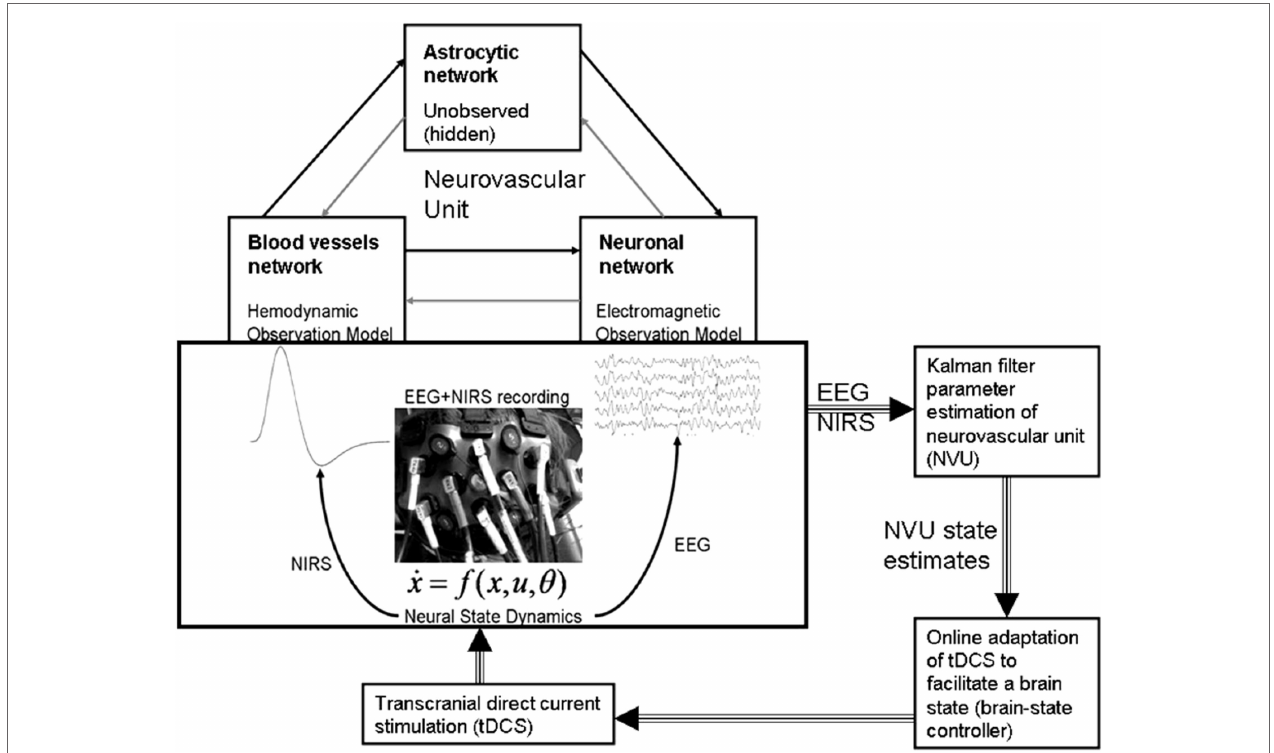
FiGUre 5 | neurovascular unit (nVU) that consists of the endothelium, glia, neurons, pericytes, and the basal lamina . Computational model for the interactions between the hemodynamic and electrophysiological responses, captured with NIRS–EEG joint imaging, may help in online modulation of tDCS. Figure adapted from Dutta et al. (19,